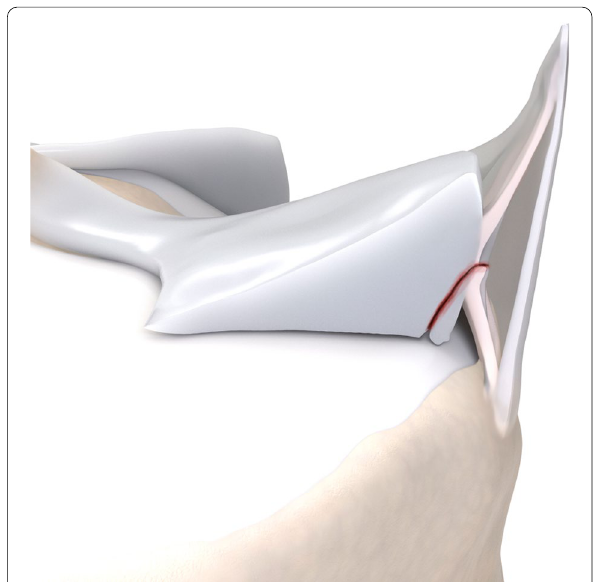
Fig. 8 Type 3B meniscal ramp lesion illustration, defined as a partial inferior tear affecting the meniscotibial ligament